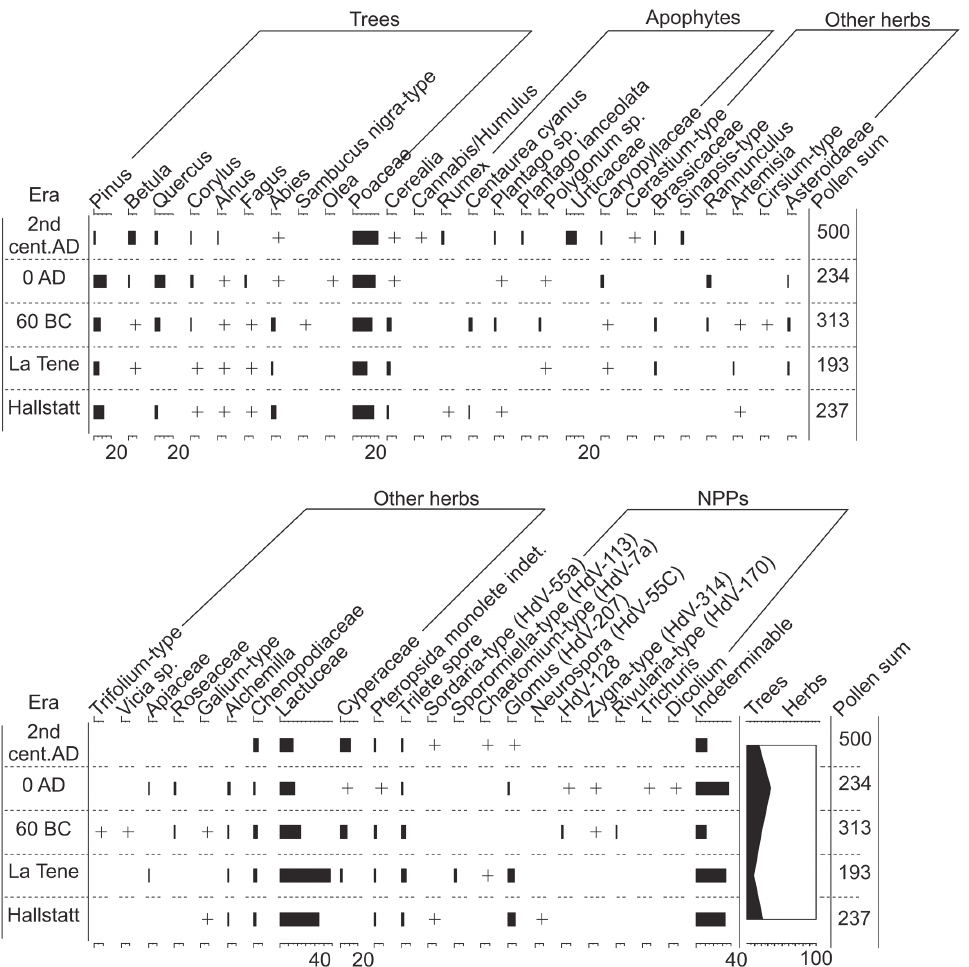
Fig 5. Percentage pollen and spore diagram for archaeological samples, displaying selected taxa (based on the TLP sum). Also shown is the summary diagram and pollen sum for each sample. + indicates < 1%